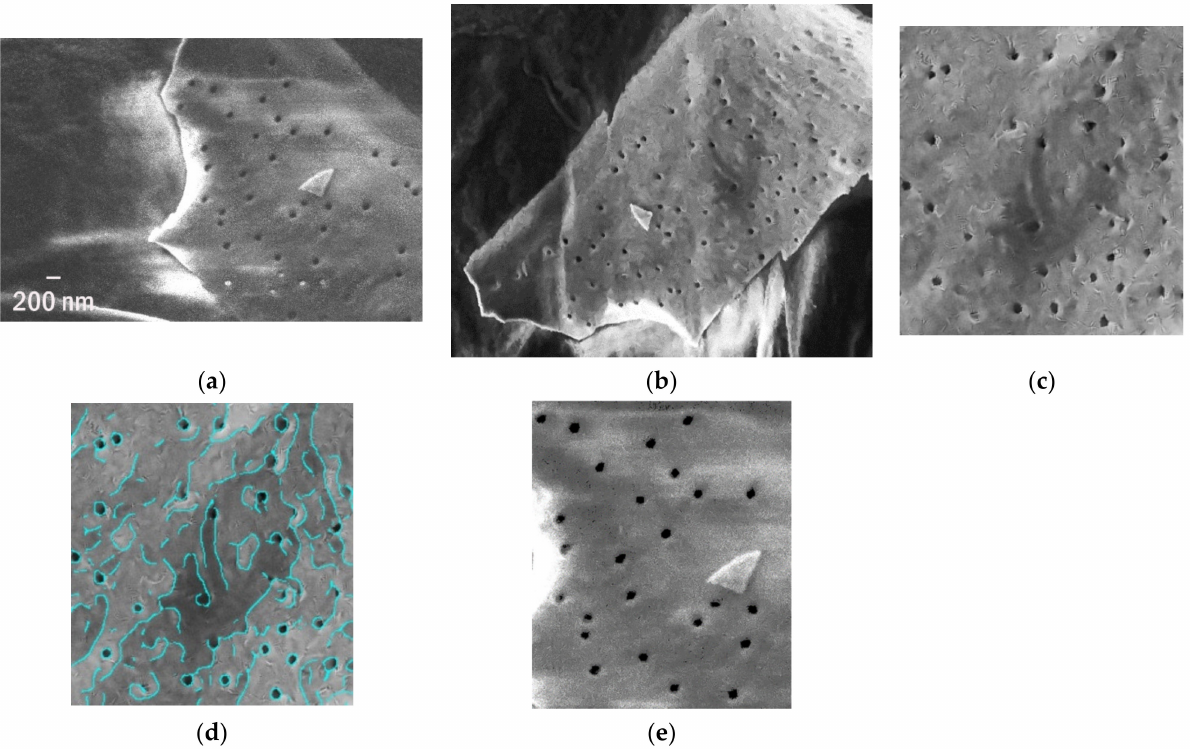
Figure 5. The MPs from Southern Baltic and its perforation: ( a , b ) the fragment and whole debris, ( c , d ) the magnified piece of debris and marked detected edges, ( e ) 25 holes mapped on a determined area of 6 µ m 2